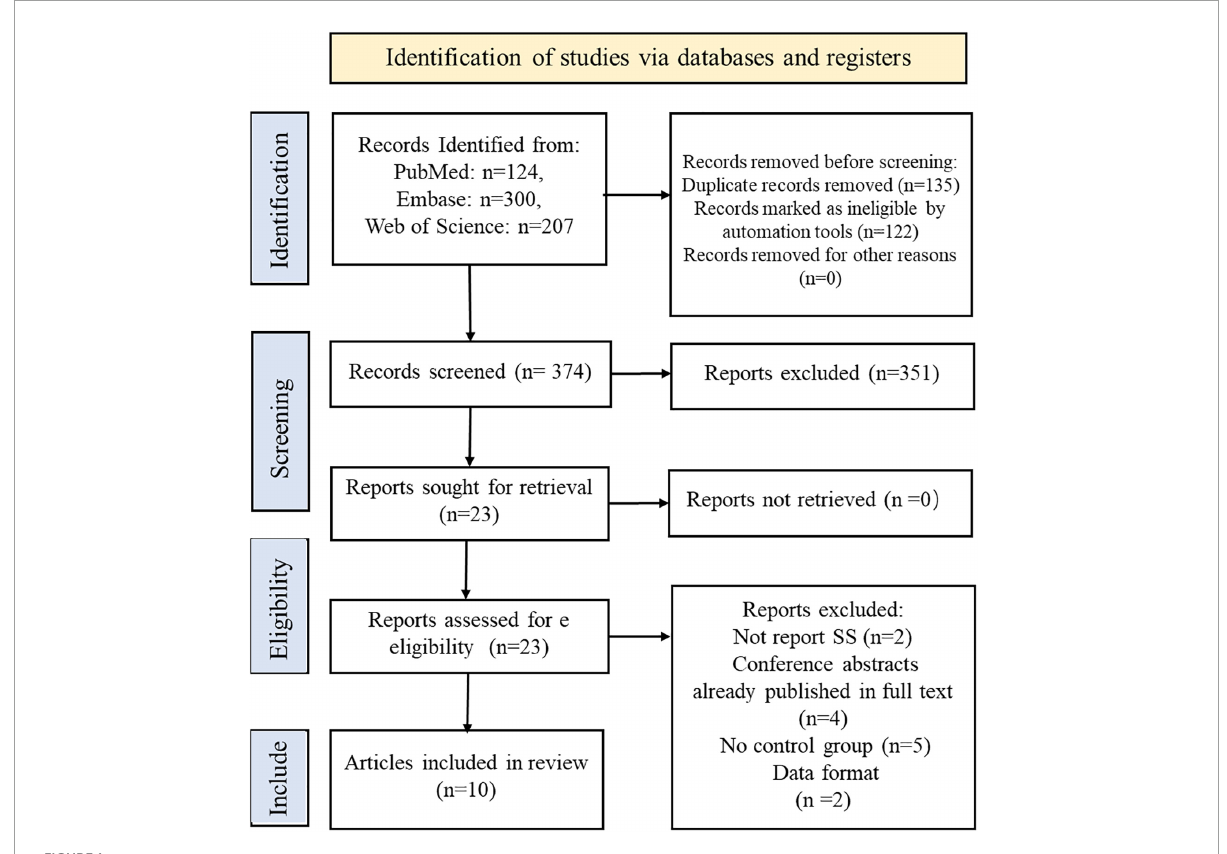
FIGURE1 Flow diagram of the study selection